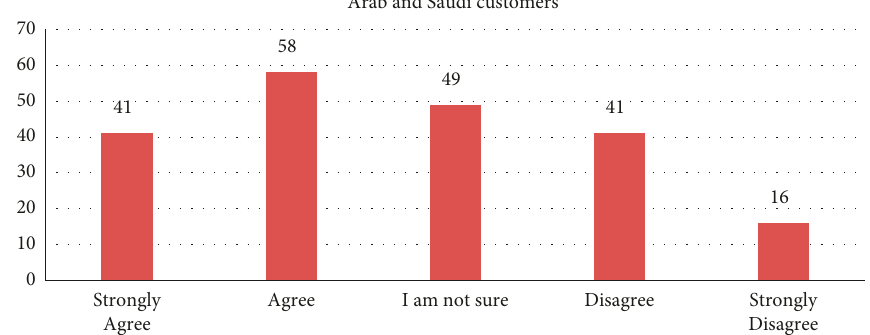
Figure 9: Participants’ responses regarding the adaptability of the Arabic version of Amazon.sa to the Saudi culture.